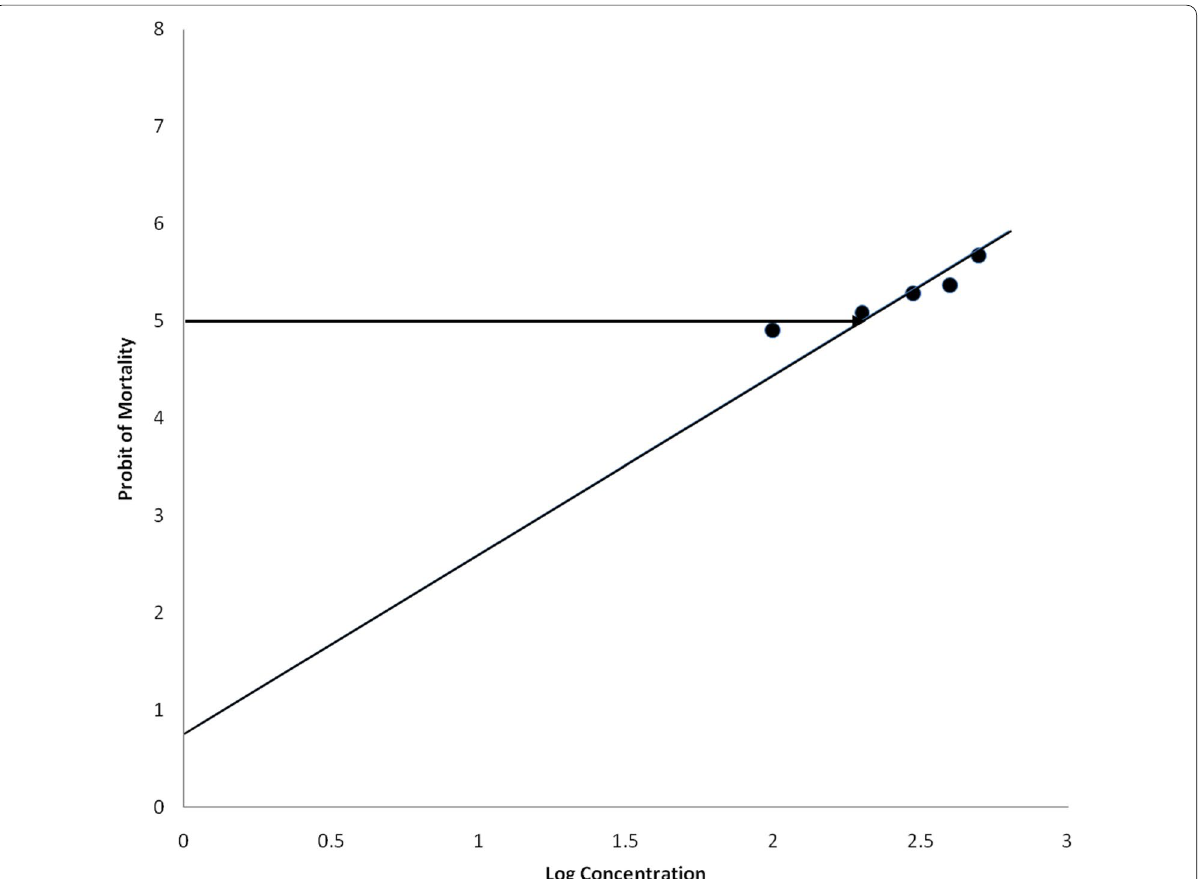
Fig. 2 Graph of Probit of Mortality of Anopheles Larvae/Log of Concentration of Ethanolic Leaf Extract of Ricinus communis Showing the LC 50 at Lethal